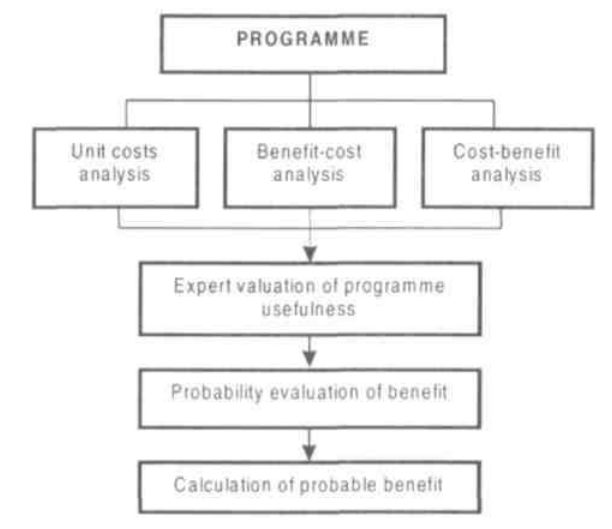
Fig 4. Principal scheme of programme efficiency